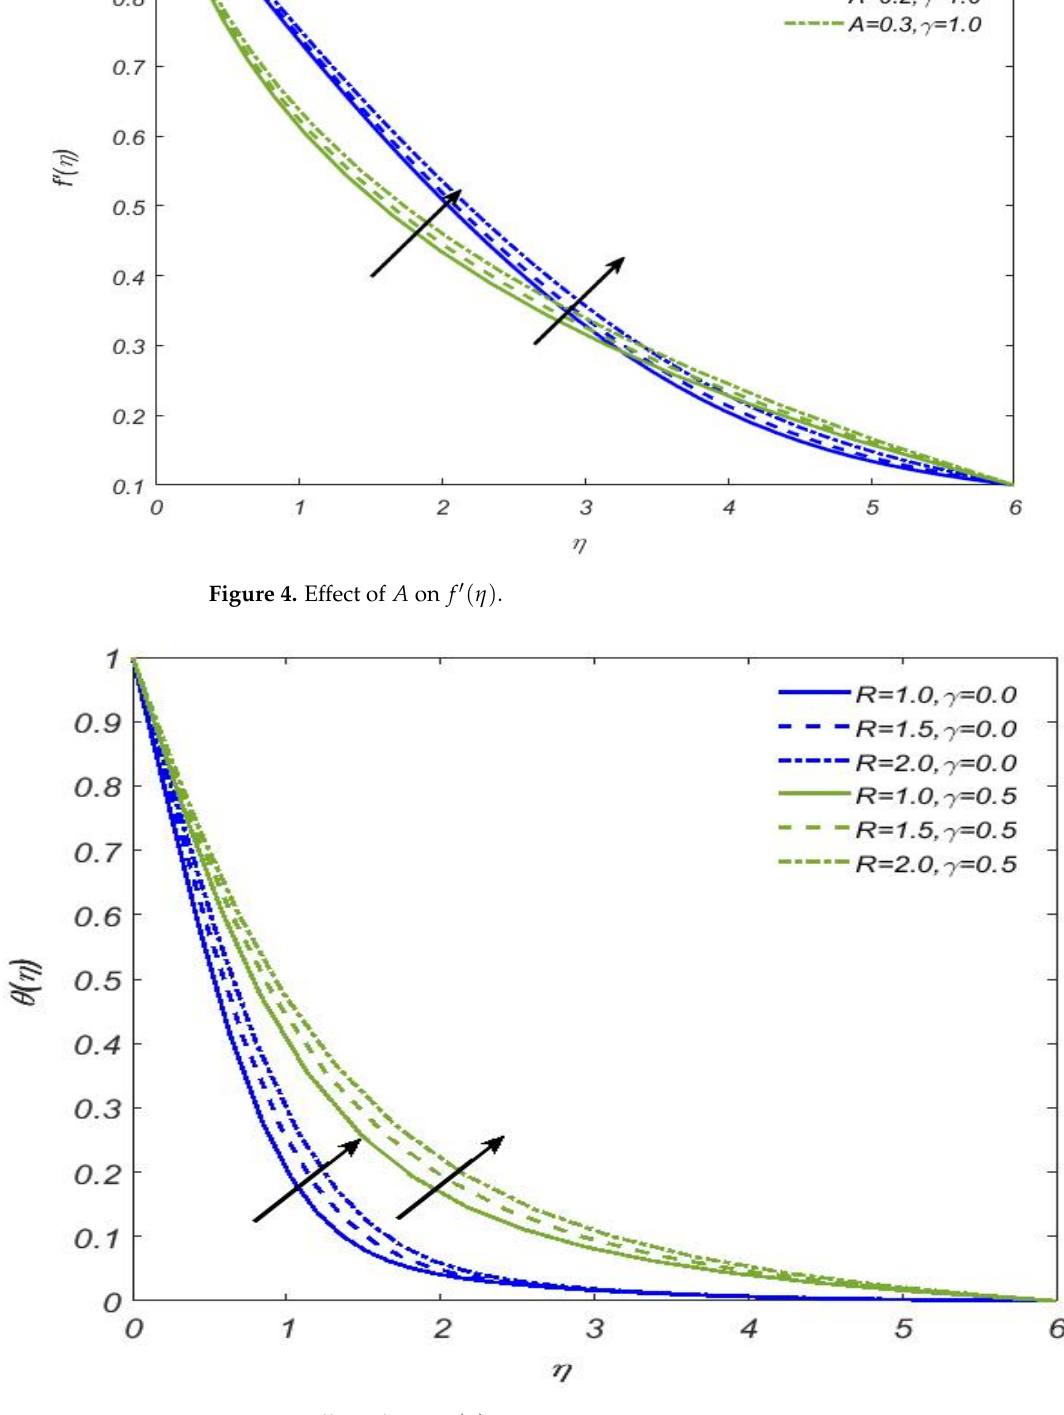
Figure 5. Effect of R on θ ( η )